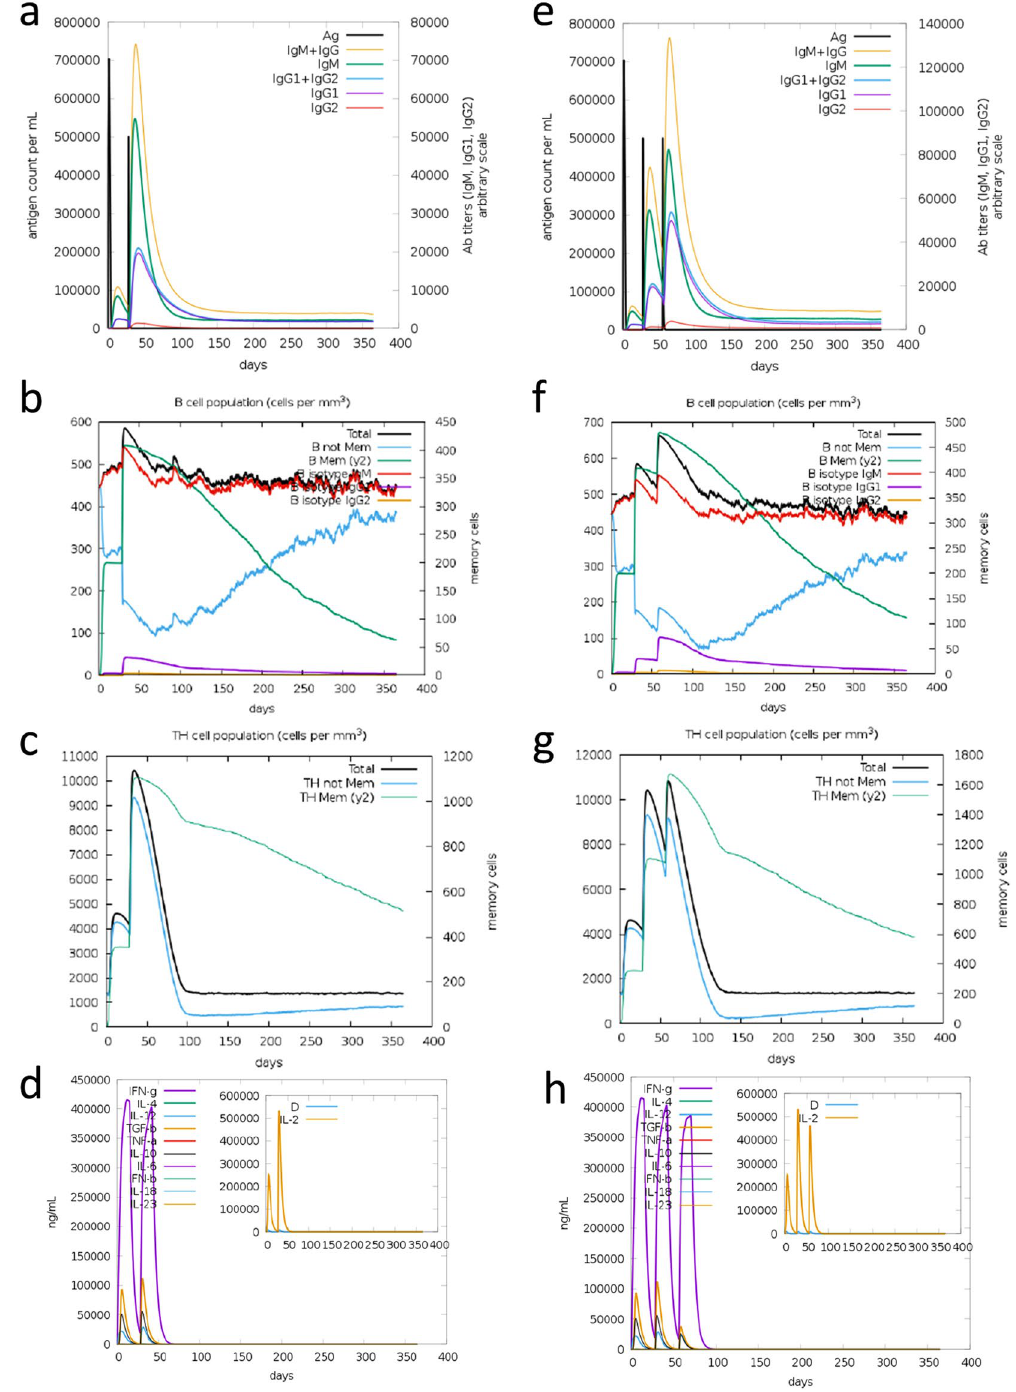
Figure 3. C-ImmSim in silico immune simulation with the designed vaccine complex. ( a–d ) Immune simulation with one booster after four weeks. ( e–h ) Immune simulation with two boosters at four and eight weeks. ( a , e ) Antibody titer following vaccine injection. ( b , f ) B-cell population upon vaccine injection. ( c , g ) The evolution of T-helper cell population. ( d , h ) Cytokines and interleukins